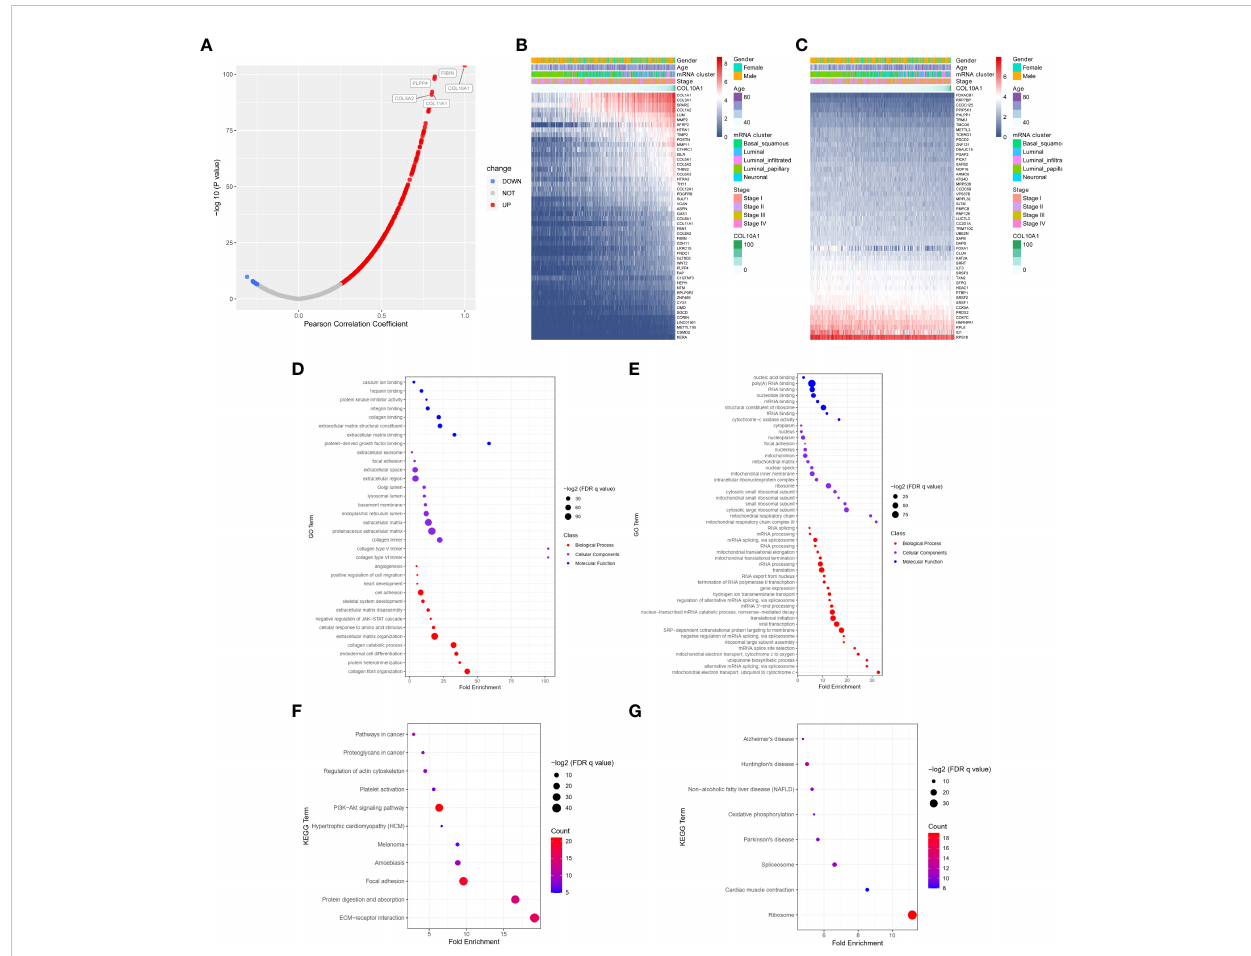
FIGURE 4 Enrichment analysis of COL10A1 gene co-expression network in BLCA. (A) The volcano map showed co-expression genes associated with COL10A1 expression in the TCGA-BLCA datasets. (B, C) Heat maps showed the top 50 co-expression genes positively and negatively correlated with COL10A1 expression in the TCGA-BLCA datasets. (D, F) Enrichment analysis of gene ontology (GO) terms and Kyoto Encyclopedia of Genes and Genomes (KEGG) terms for co-expression genes positively correlated with COL10A1. (E, G) Enrichment analysis of GO terms and KEGG terms for co-expression genes negatively correlated with